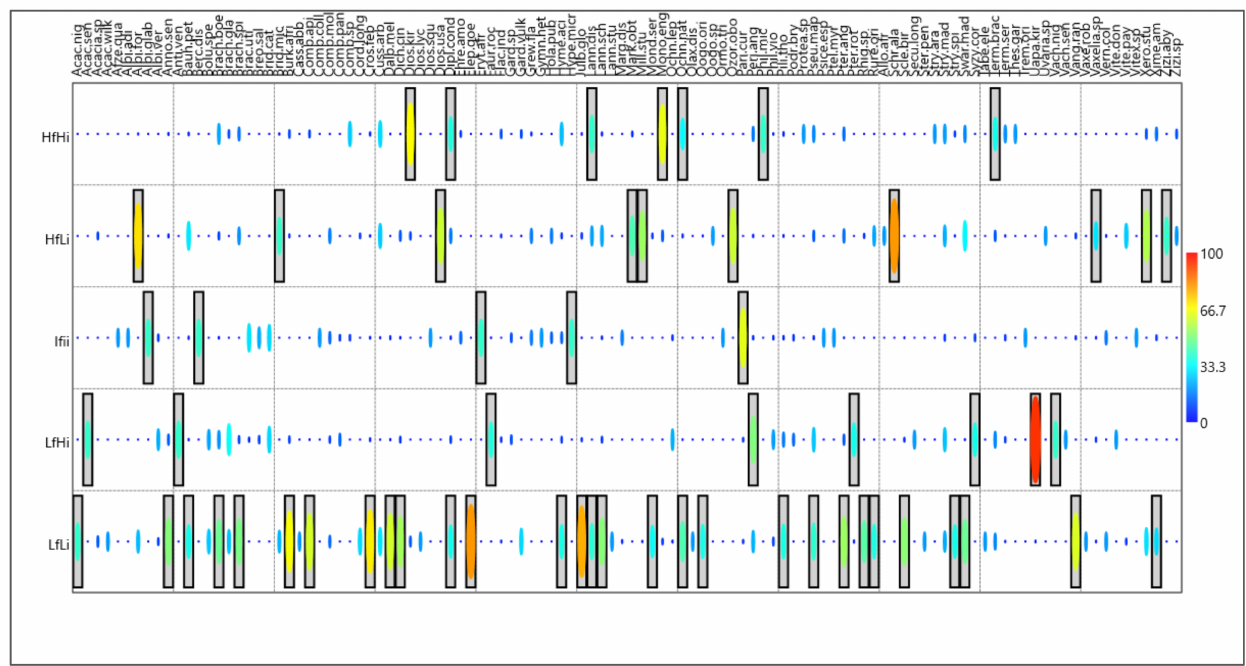
Figure 5. Indicator Value of Species (IndVal in %) for the fire strata. The statistical significances ( p < 0.05) of the indicator values are shown as boxes (species codes Table